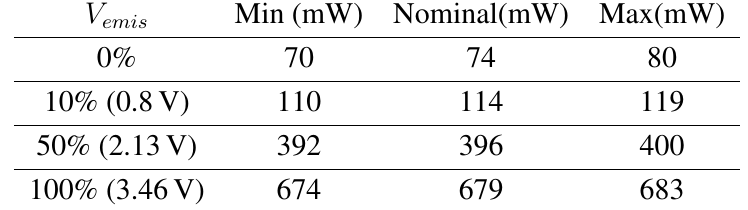
Table 1. Consumption characteristics of the board.